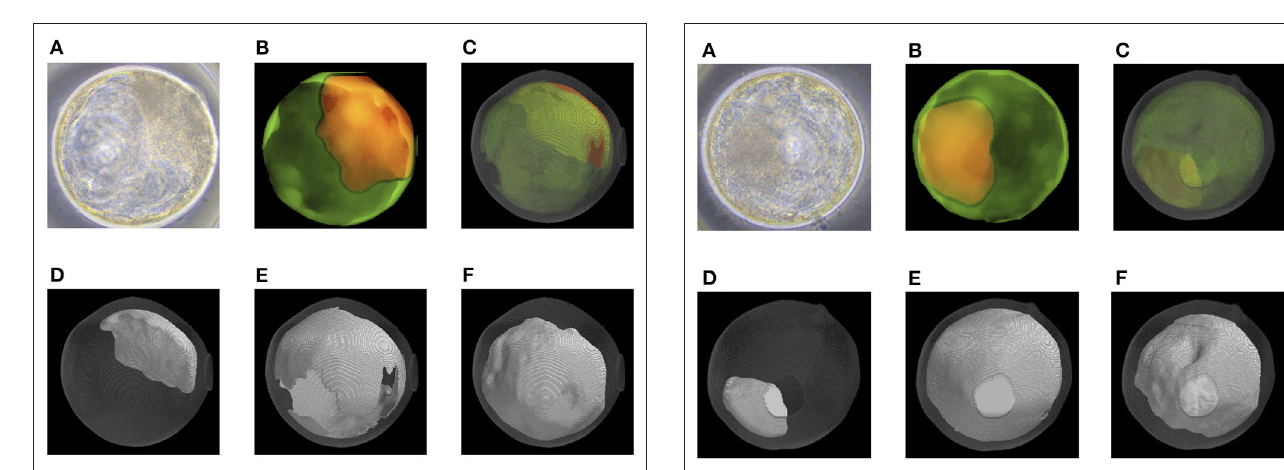
FIGURE 6 | Representative optical coherence tomography (OCT) images of a transferred bovine embryo that resulted in pregnancy. (A) A representative transferred embryo, determined as Code 1 according to the IETS standards, imaged by a microscope. (B) Sum of all pixel values in z-stack images of trophectoderm (TE; bright green) and inner cell mass (ICM; orange) part was extracted from the tomographic image and synthesized 2D image. (C) A 3D-visualization of structures of the embryo, including ICM (orange), TE (bright green), zona pellucida (ZP; gray), and blastocoel. (D–F) A 3D visualization of each structure of the embryo: ICM (D) , TE (E) , and blastocoel (F) . Colors in (B–F) are graphically added. See also Supplementary Movies 1 – 4 for the 3D images of (C–F) , respectively.